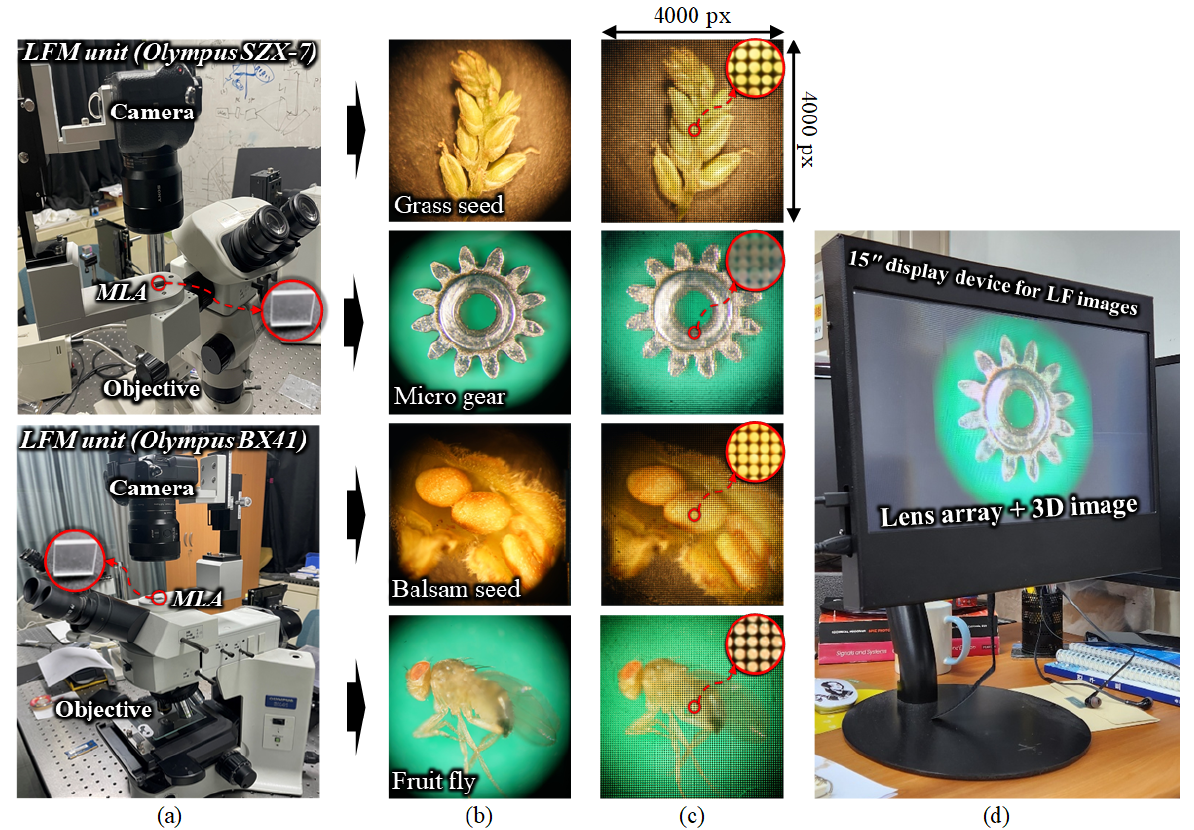
Figure 2. ( a ) Stereo LFM unit for low magnification (top) and biological LFM unit for high magnifica- tion (bottom), ( b ) high-resolution 2D images, ( c ) corresponding EIAs of the grass seed, micro gear, balsam seed, and fruit fly samples, and ( d ) a prototype of the 3D LF display unit. Table 1. Device specifications for the implemented